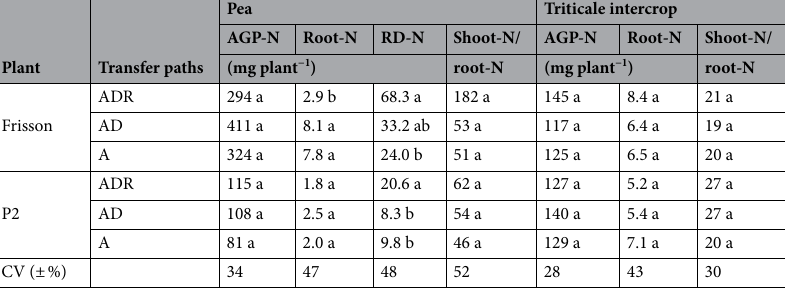
Table 3. Mean N amounts per plant in above-ground plant (AGP) biomass, root biomass, and rhizodeposition (RD) of two pea varieties and triticale as intercrop at the end of a 105-day greenhouse pot experiment; transfer paths: ADR = AMF, diffusion, and root contact between pea and intercrop; AD = AMF and diffusion; A = only AMF; CV = mean coefficient of variation between replicate pots (n = 6); different letters within a pea-specific treatment indicate a significant difference (protected LSD test; P < 0.05).